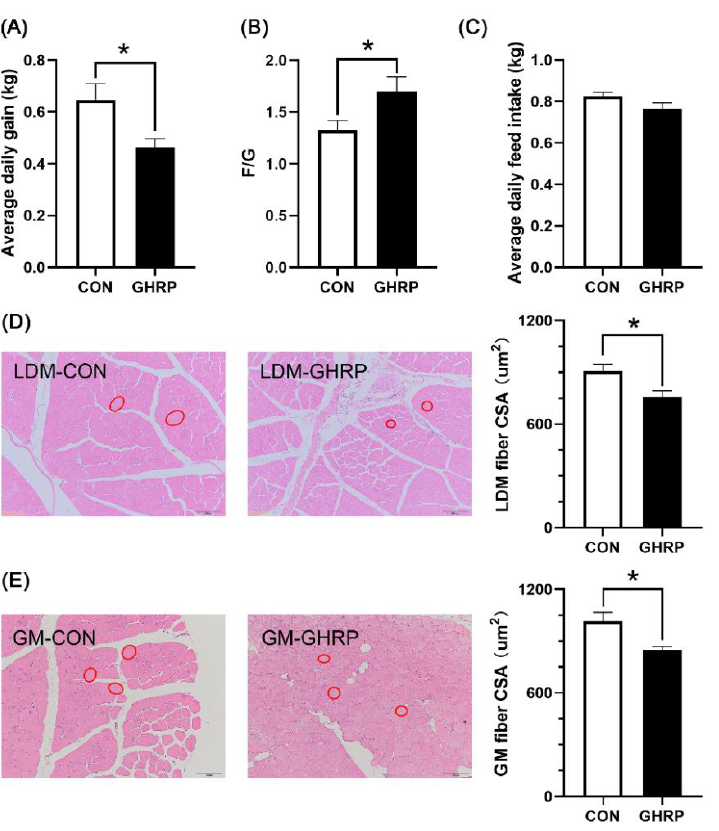
Figure 1. Effects of injection of ghrelin antagonist ([D-Lys3]-GHRP-6) on the growth performance and morphology of muscles in pigs. Average daily gain ( A ), feed conversion ratio ( B ) and average daily feed intake ( C ) over the 7 d trial period, and the cross-sectional areas (CSA) of longissimus dorsi muscle ( D ) and gastrocnemius muscle ( E ) fibers were measured after 7 d of injection of [D-Lys3]-GHRP-6 (GHRP) or saline (CON). Values are means ± SEMs; n = 6. * p < 0.05 versus control group. LDM: longissimus dorsi muscle; GM: gastrocnemius muscle. The red circle indicates the cross section of muscle fibers.